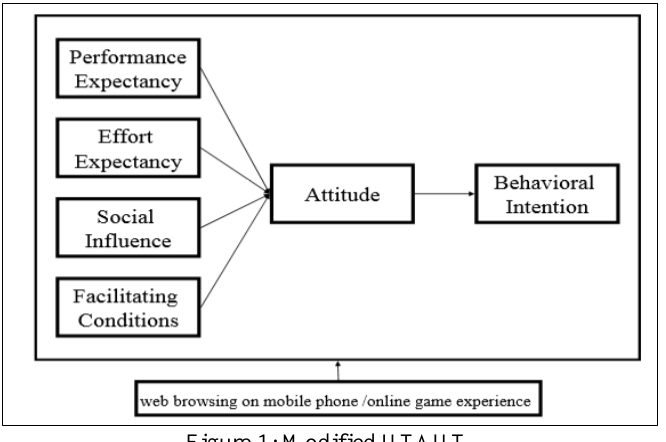
Figure 1: Modified UTAUT. Source: [21].